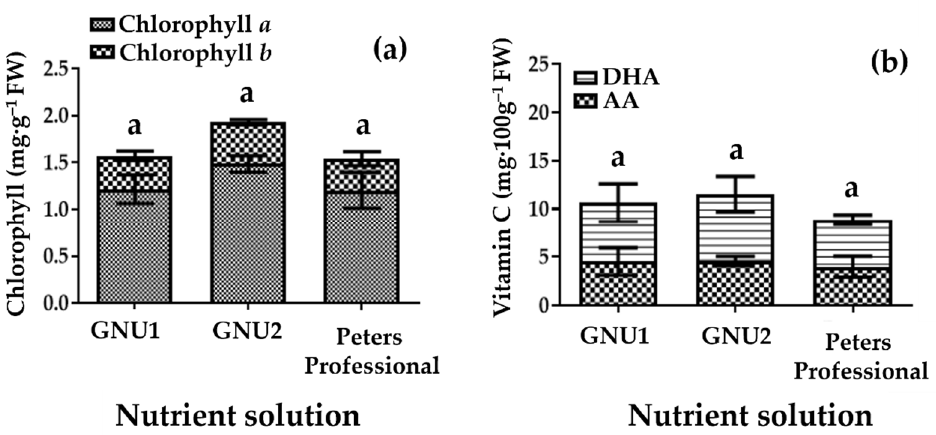
Figure 5. Contents of chlorophyll a and b ( a ) and contents of ascorbic acid (AA) and L-dehydroascorbic acid (DHA) ( b ) in Ssamchoo as affected by the nutrient solution 28 days after sowing in Experiment 1. Since ascorbic acid is easily oxidized into L-dehydroascorbic acid, vitamin C was calculated as the total ascorbic acid (TAA), a sum of AA and DHA. Peters Professional, GNU1, and GNU2 were the nutrient solutions used in the experiment. Peters Professional is a commercial nutrient solution. Vertical bars represent the SEs of three biological replicates ( n = 3). Significant differences among treatments are indicated by lowercase letters at p ≤ 0.05 according to the Duncan’s multiple range test.